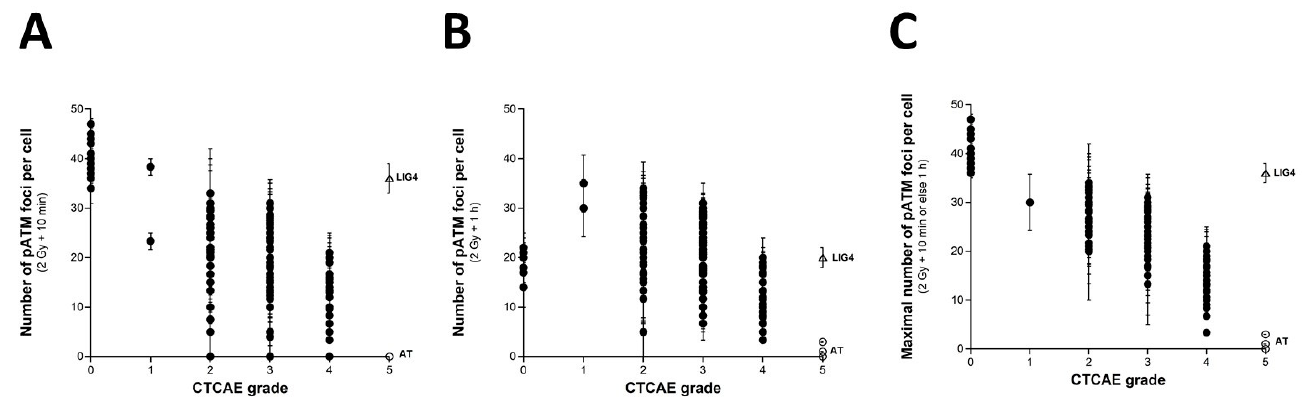
Figure 6. γ H2AX foci vs . CTCAE grades . The number of pATM foci per cell assessed 10 min ( A ) or 1 h ( B ) post-irradiation from 200 COPERNIC cell lines was plotted against the corresponding CTCAE grade values (closed circles). Each point corresponds to the mean ± standard error of the mean (SEM) of 3 independent triplicates, at least. ( C ) The maximal number of pATM foci per cell among the 10 min and 1h data shown in panels ( A , B ) was plotted against the corresponding CTCAE grade values (closed circles). The best data fit was obtained with the linear law: pATMmax (grade) = 41.72 − 6.78 × grade (r 2 = 0.74) (dotted line). The points corresponding to the ATM - (open circles) and the LIG4 - (open triangles) mutated cell lines are indicated.